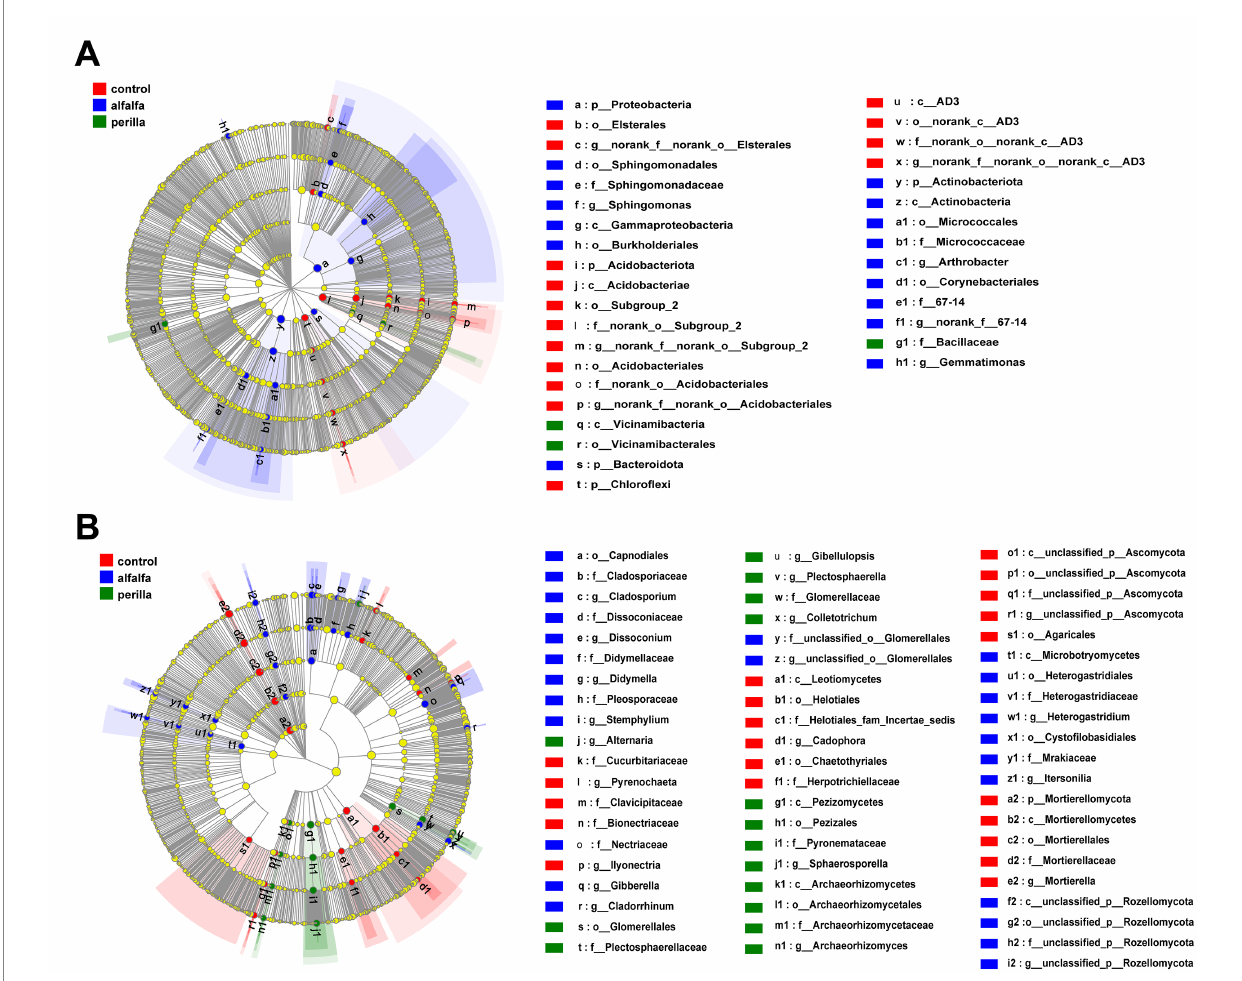
FIGURE 6 LEfSe analysis of (A) bacterial and (B) fungal communities in different treatments. Control, no treatment; Alfalfa, alfalfa cultivation; Perilla, perilla